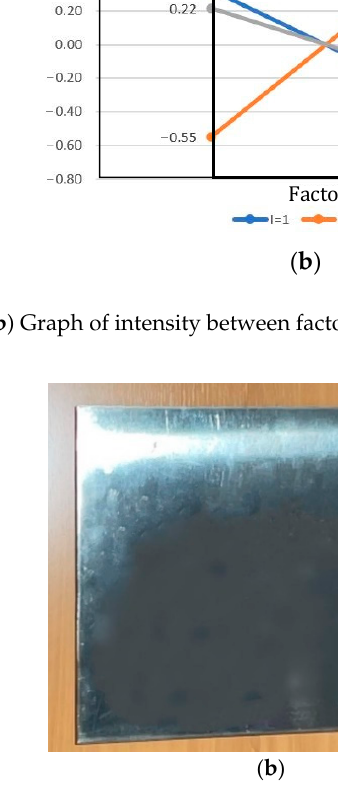
Figure 11. ( a ) Wooden plate (diffuse reflection) and ( b ) aluminium plate (specular reflection): the visual impact shows the strong light reflection of a specular surface compared to a diffuse surface. Table 4. Effect of different factors in the tests (mm).